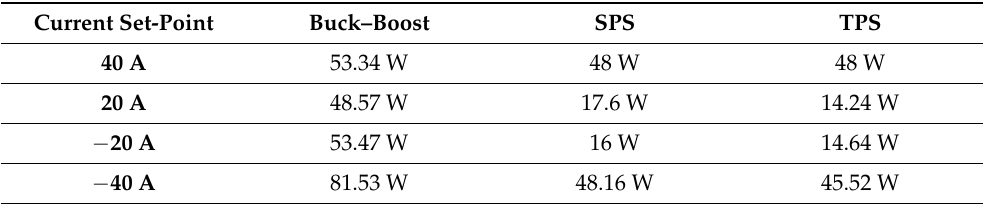
Table 6. Buck–boost and DAB converters conduction and switching losses at different current set-points.